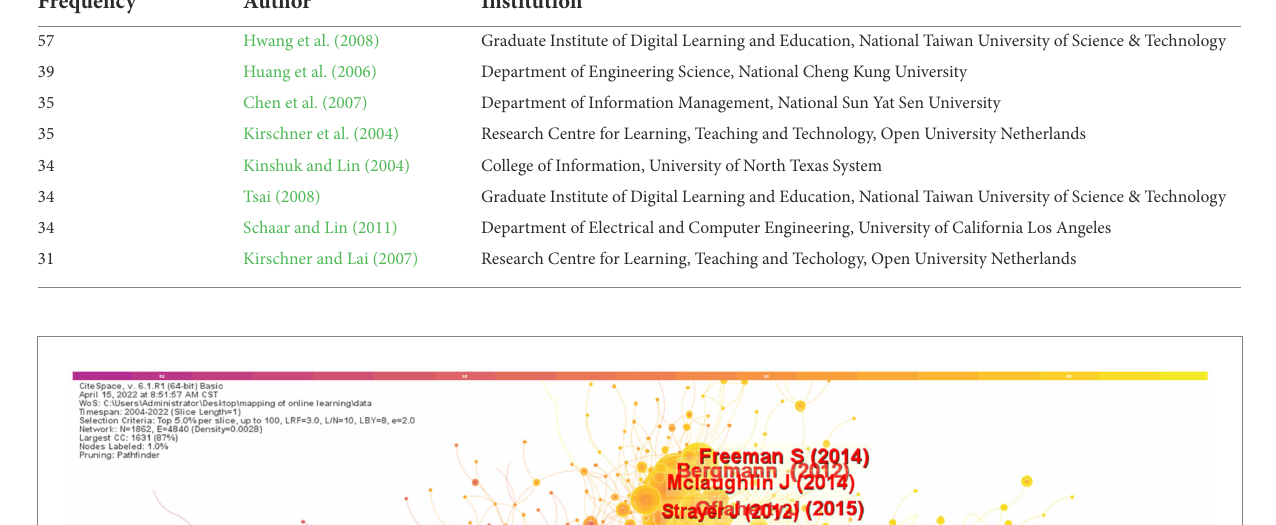
TABLE 4 Top 10 authors based on frequency.